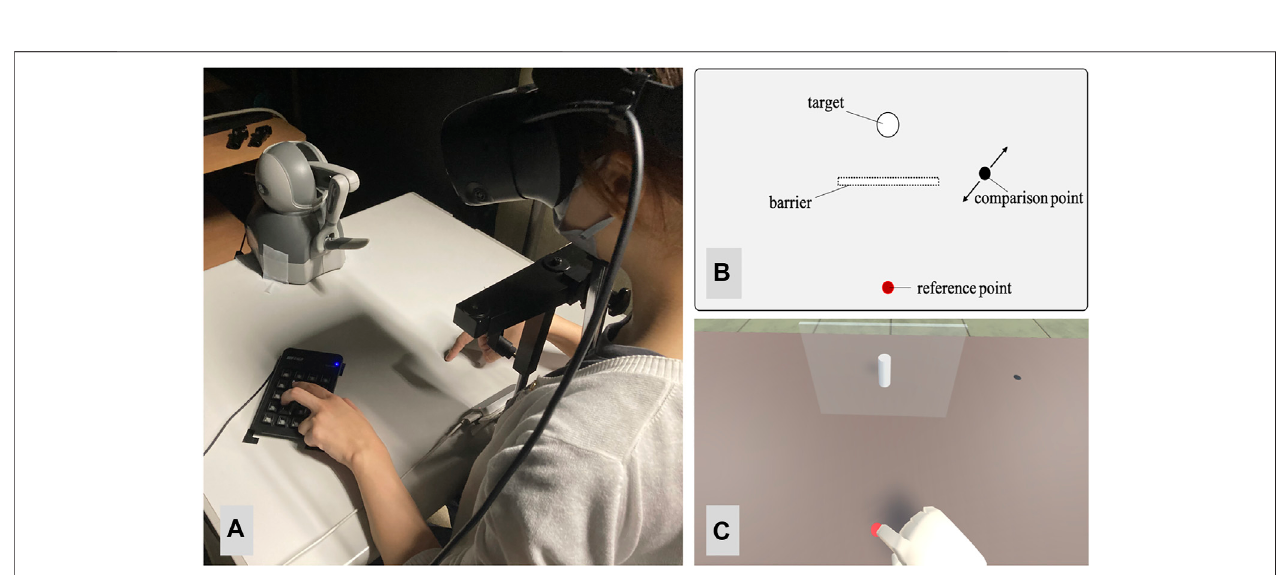
FIGURE 2 | The distance estimation task. In this task, a virtual right-hand avatar that moved synchronously with the participant ’ s right hand was presented in the virtual environment. The participants put their right index fi nger on the red reference point and estimated the distance between the reference point and the target. Then, they adjusted the comparison point until the distance between the reference point and the comparison point matched the distance between the reference point and the target.